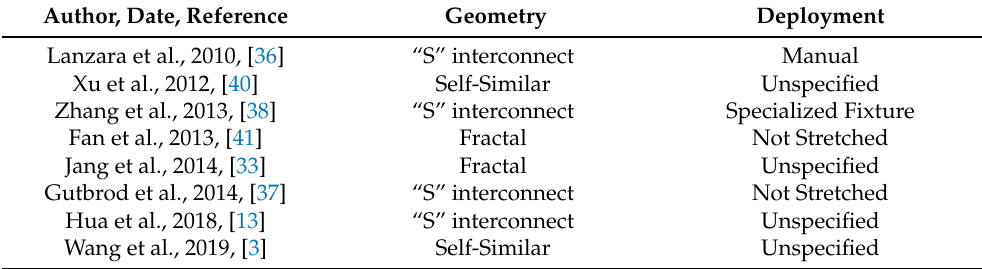
Table 2. Summary of the expandable sensor network literature (geometries and deployment